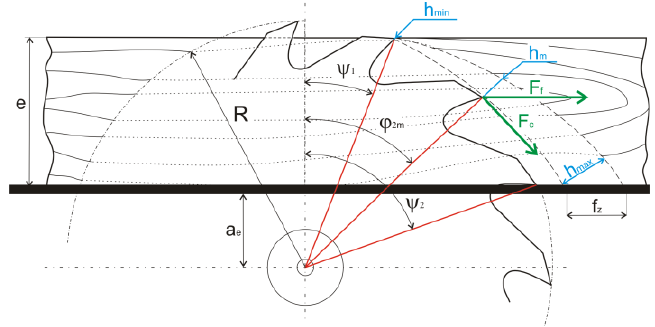
Figure 3. Circular sawing process scheme: e —workpiece height; a e —position of the workpiece; R — circular sawblade radius; ψ 1 —entry angle; ψ 2 —exit angle; ϕ 2 m —mean fiber cutting angle; h min —minimum uncut chip thickness; h m —mean uncut chip thickness; h max —maximum uncut chip thickness; F c —cutting force; F f —feed force; f z —feed per